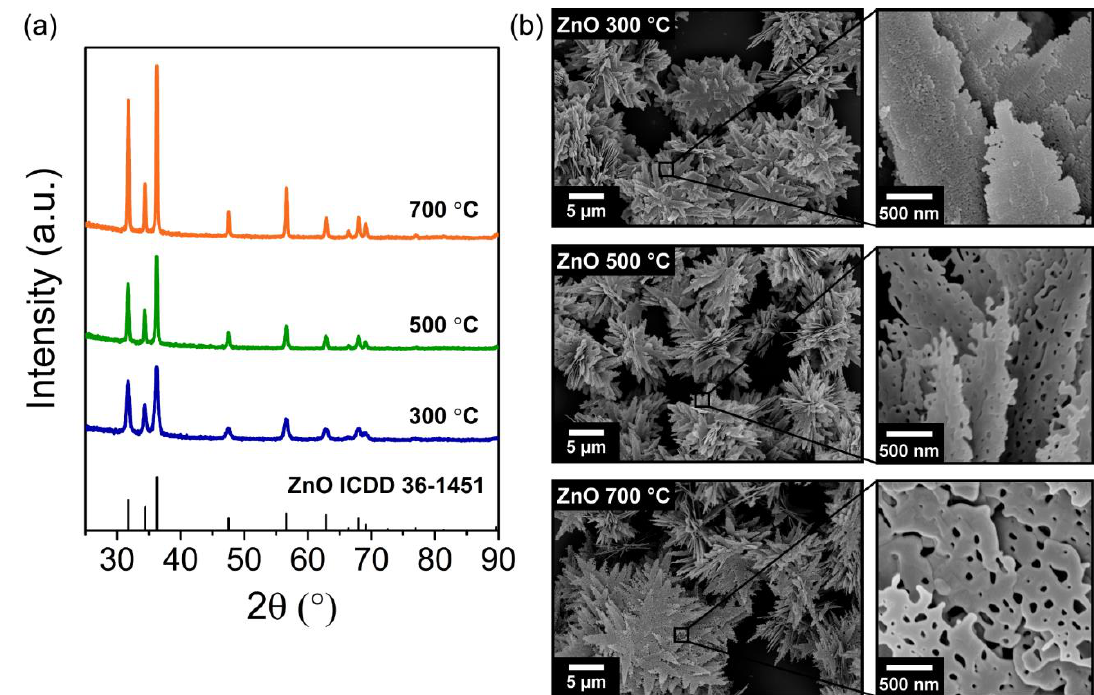
Figure 1. ( a ) XRD diffractograms and ( b ) SEM images of porous ZnO nanostructures synthesized via the hydrothermal method (assisted by microwave irradiation) and calcinated at 300, 500, and 700 °C.